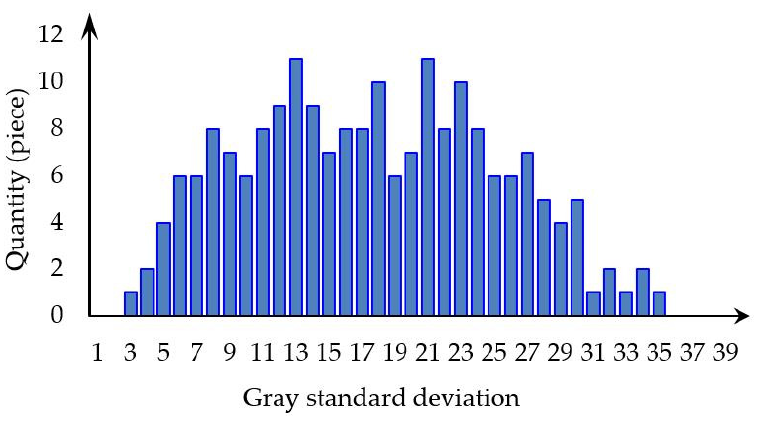
Figure 14. Global constraint threshold analysis.